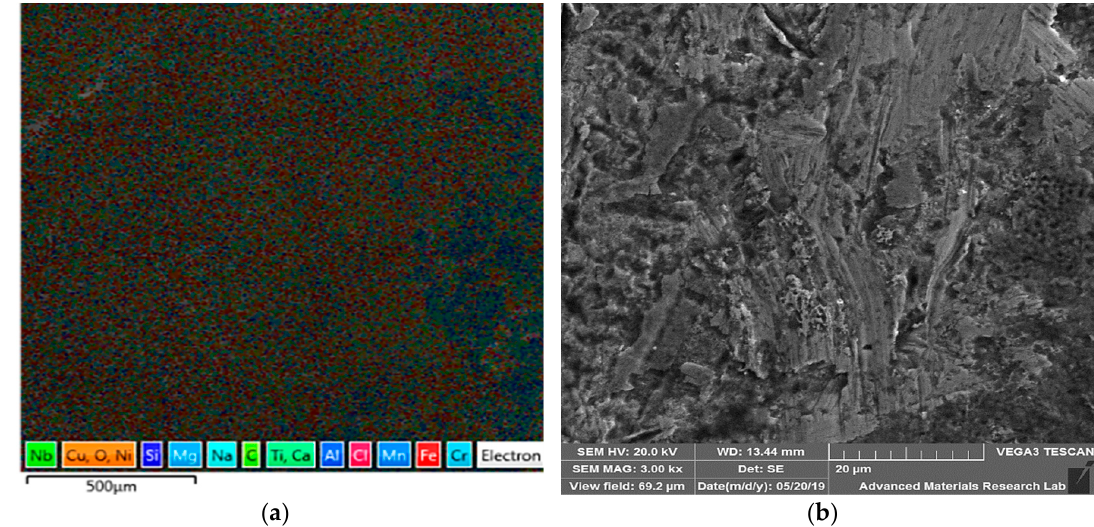
Figure 6. EDS and SEM for CT specimen; ( a ) specimen CT-EDS mapping for weld; ( b ) specimen CT-SEM on weld.